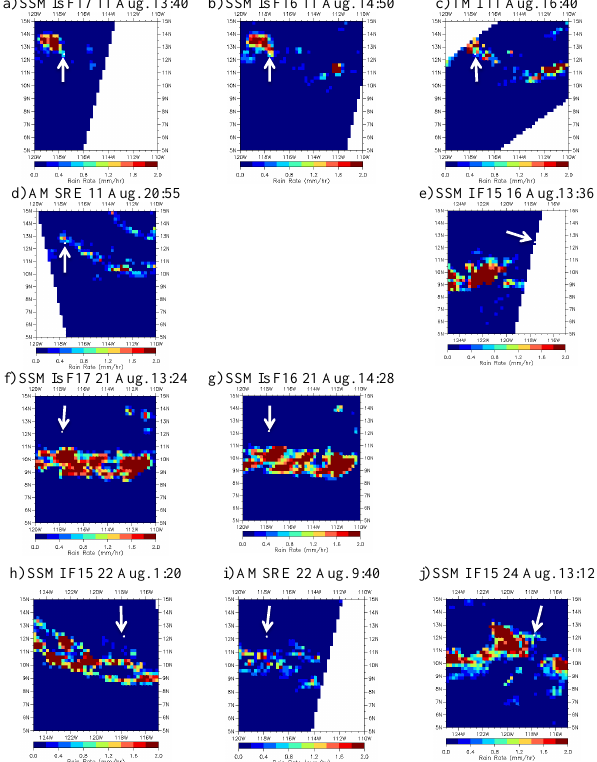
Fig. 5. Satellite RR close in space and time to ARGO profiles and SMOS passes shown in Fig. 4. The location of the ARGO float is indicated by a white point and a white